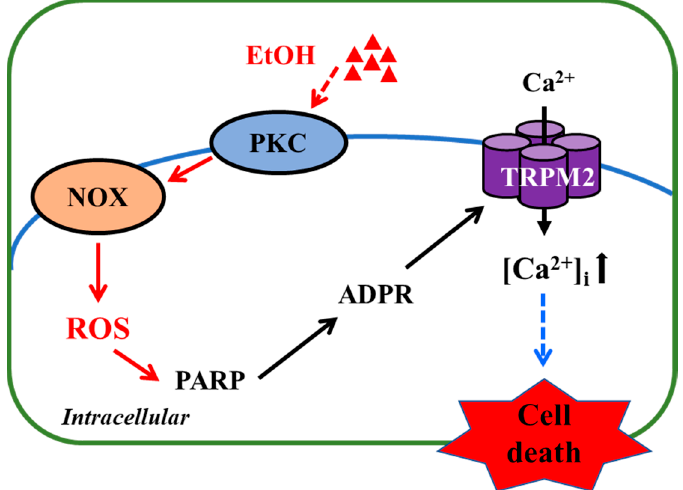
Figure 5. TRPM2-mediated signaling mechanism for EtOH-induced microglial cell death. Exposure to EtOH stimulates PKC and NOX to generate ROS, which, in turn, induce PARP-dependent ADP-ribose (ADPR) production and subsequent TRPM2 channel activation, leading to an increase in intracellular Ca 2 + concentrations ([Ca 2 + ] i ) and cell death. Abbreviations: PKC, protein kinase C; NOX, nicotinamide adenine dinucleotide phosphate oxidase; ROS, reactive oxygen species; PARP, poly (ADP-ribose) polymerase; ADPR, ADP-ribose.